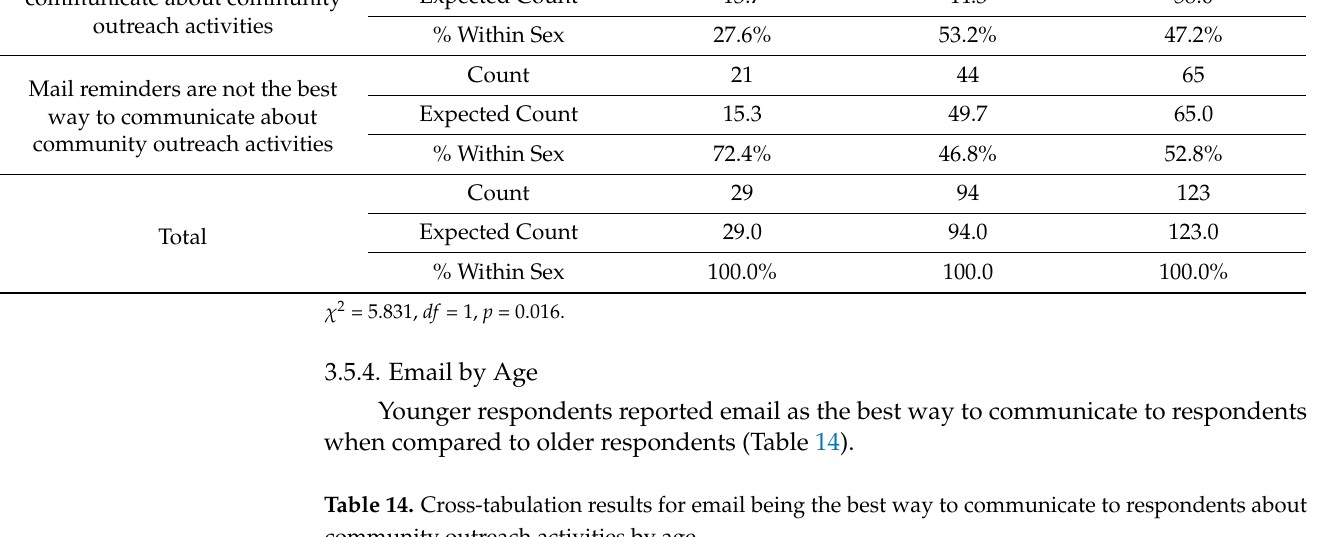
Table 14. Cross-tabulation results for email being the best way to communicate to respondents